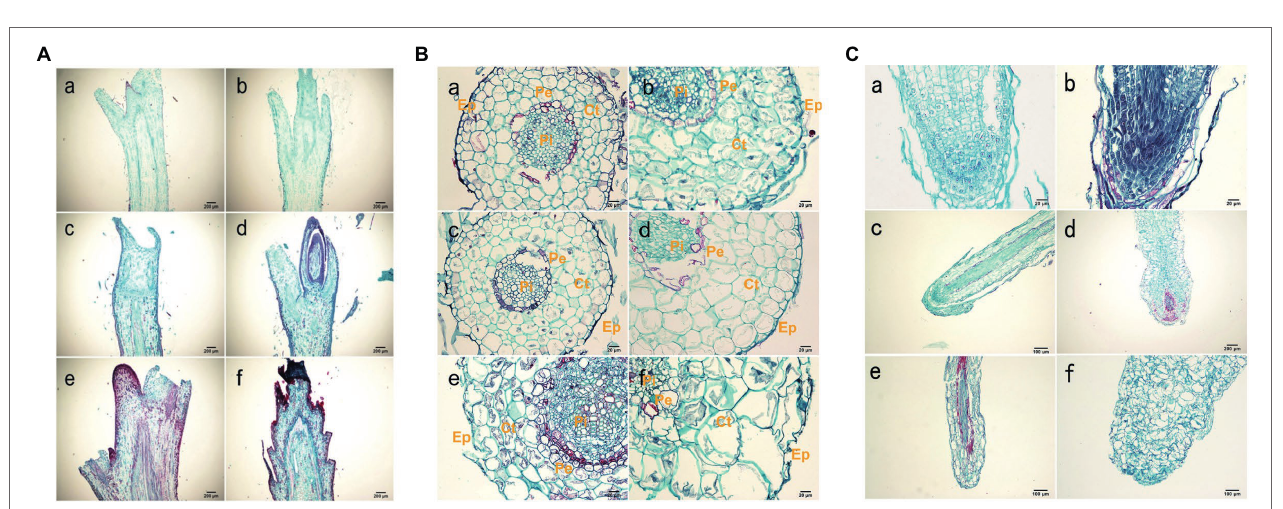
FIGURE 3 | Histological observations of roots. (A) Anatomy of a shoot tip longitudinal-section from hybrid sweetgum. a,c,e Cross-section of a diploid shoot tip; b,d,f crosssection of a tetraploid shoot tip. a,b 25 d; c,d 50 d; e,f 70 d. Each bar is 200 μ m. (B) Anatomy of a typical root cross section from hybrid sweetgum. a,c,e Cross-section of a diploid root; b,d,f cross-section of tetraploid roots. a,b 25 d; c,d 50 d; e,f 70 d. Ep: epidermis; Ct: cortex; Pi: pith; CC: central cylinder; Pe: pericycle. Bars are 100 μ m in a,b,e,f ; they are 20 μ m in c,d . (C) Anatomy of a typical root tip longitudinal-section from hybrid sweetgum. a,c,e Cross-section of diploid root tips; b,d,f cross-section of tetraploid roof tips. a,b 25 d; c,d 50 d; e,f 70 d. Each bar is 200 μ